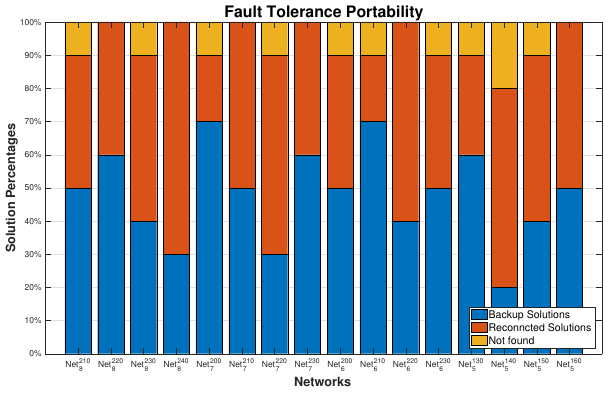
Figure 14. Determining the fault-tolerance Backbone on big-size